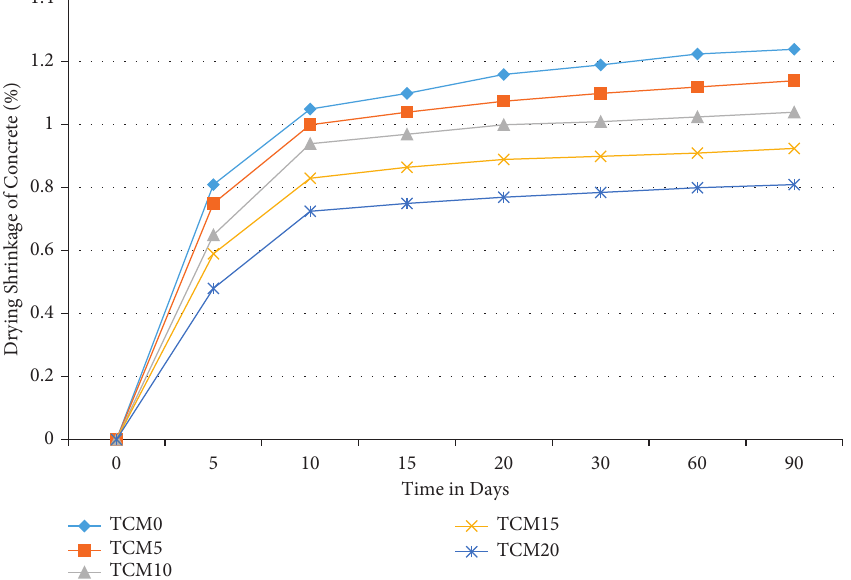
Figure 12: Drying shrinkage of